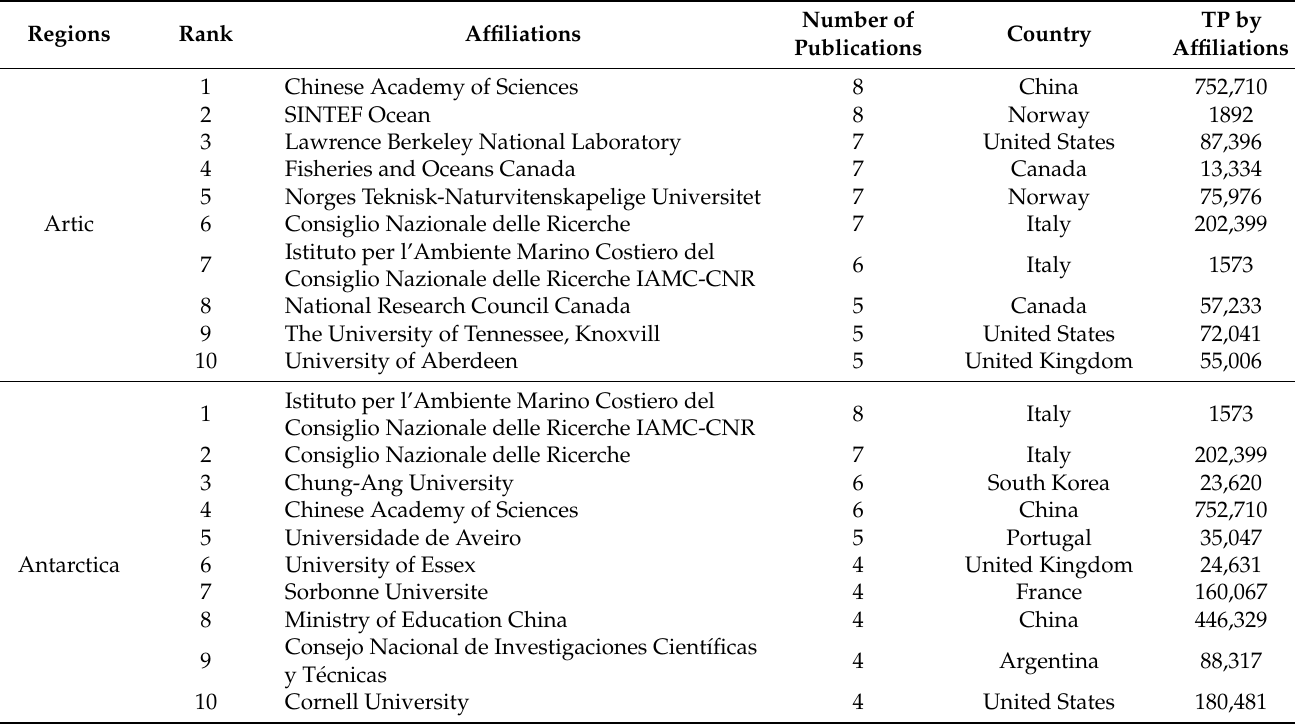
Table 1. Top ten ranked affiliations with the number of publications between 2009 and 2019 based on the research on degradation of hydrocarbon by Arctic and Antarctic marine